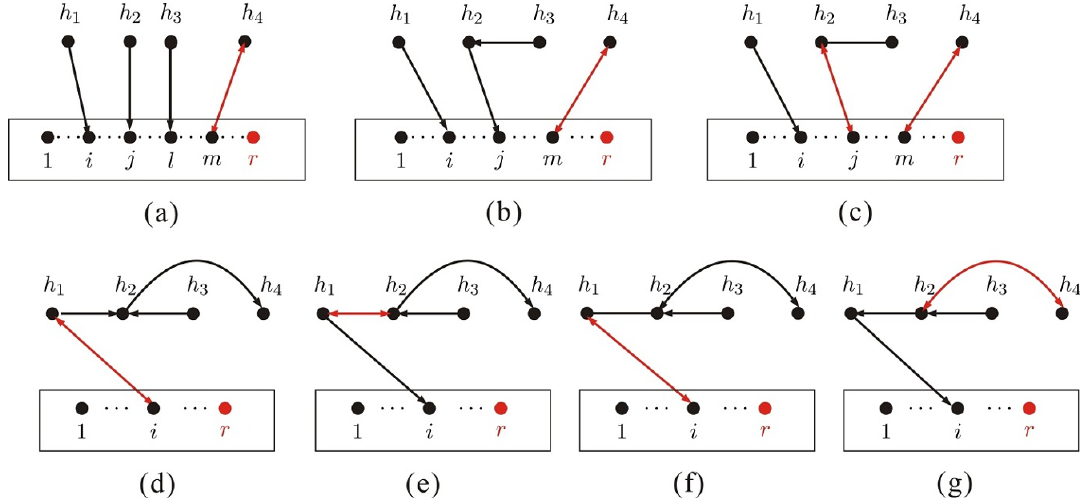
Figure 5 . Graphs constructed by the re(cid:12)ned graphic rule. The graph (a) corresponds to the old-version graph (cid:12)gure 4 (a), the graphs (b) and (c) correspond to the old-version graph (cid:12)gure 4 (b), while the graphs (d)-(g) correspond to the old-version graph (cid:12)gure 4 (c).